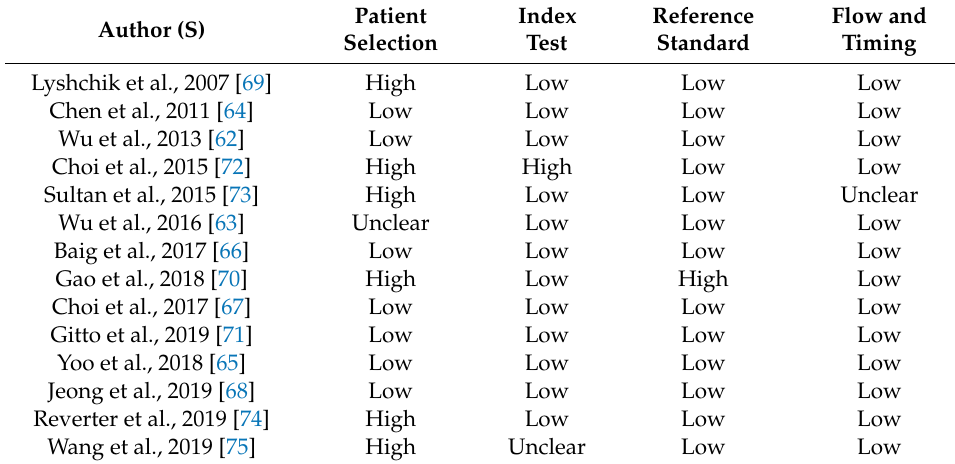
Table 4. Quality assessment of diagnostic accuracy studies (QUADAS) bias results.